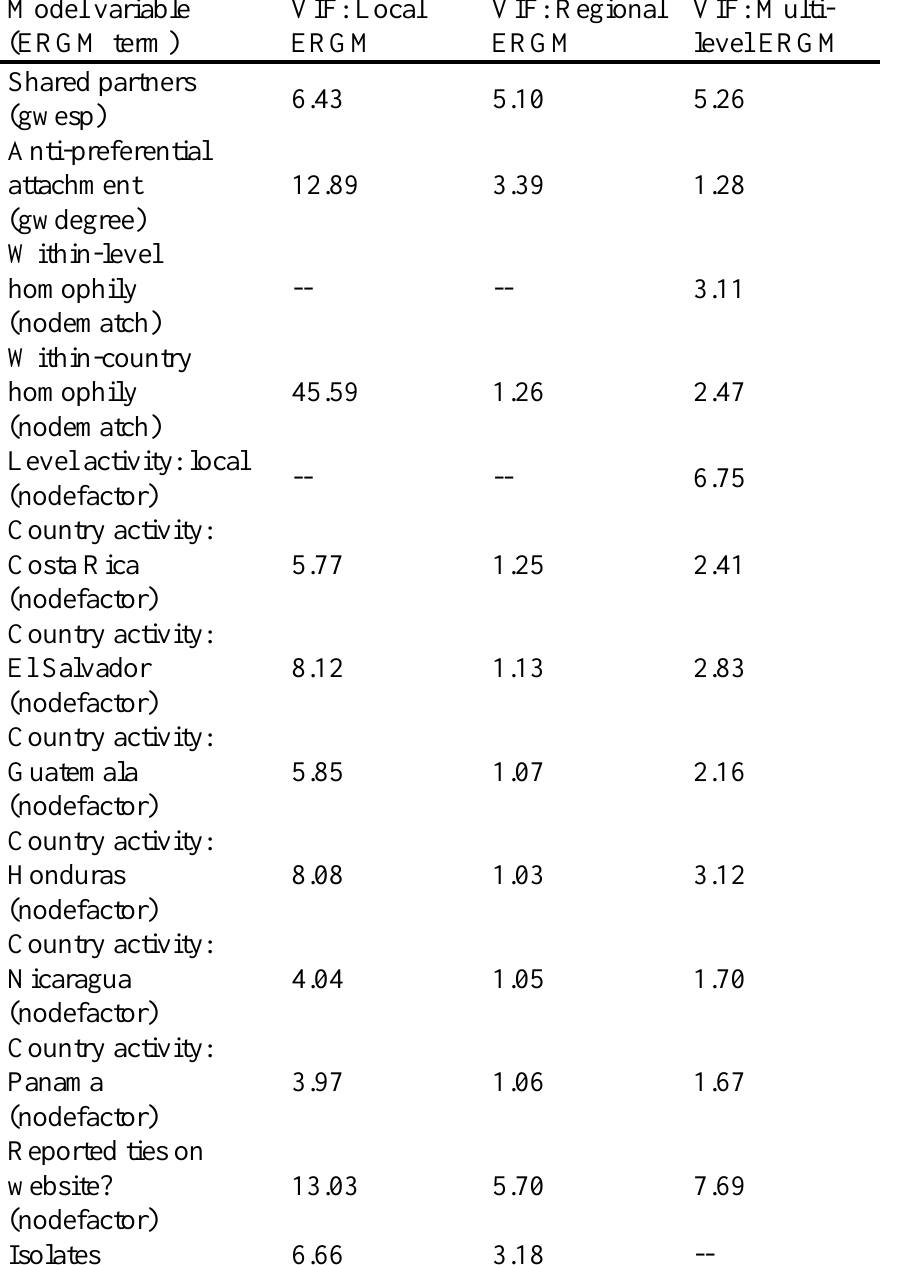
Table A4.1: Results from calculating the variance inflation factor (VIF) for the model terms in the local, regional, and multi-level